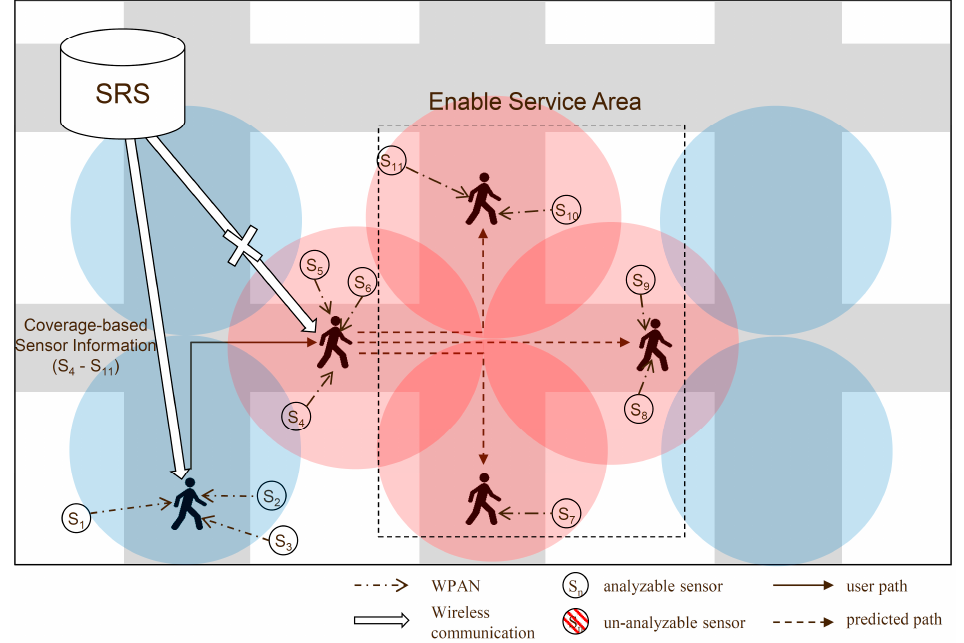
Figure 7. Example of sensor information received using coverage information.